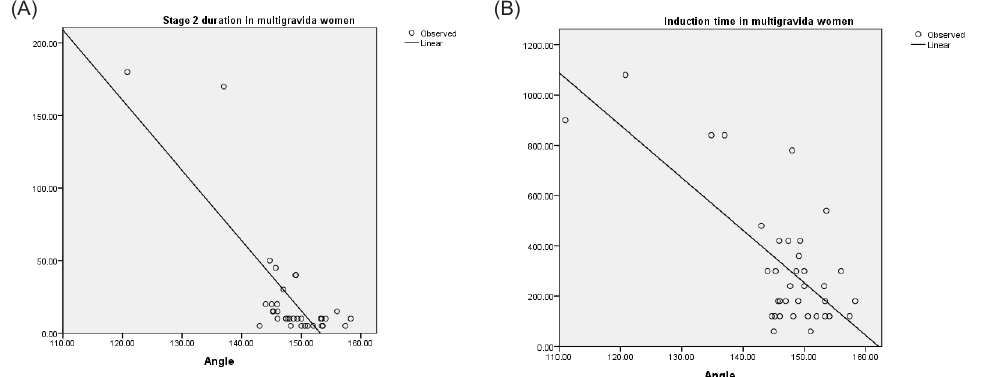
Figure 4. ( A) Correlation between angle of progression and induction time in multigravida women. (B) Correlation between angle of progression and induction time in multigravida